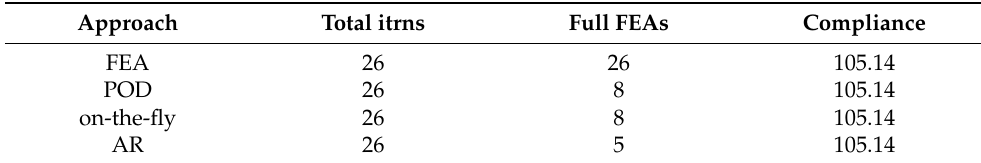
Table 1. Bridge test example: Results of each MOR approach as well as the classic implementation.